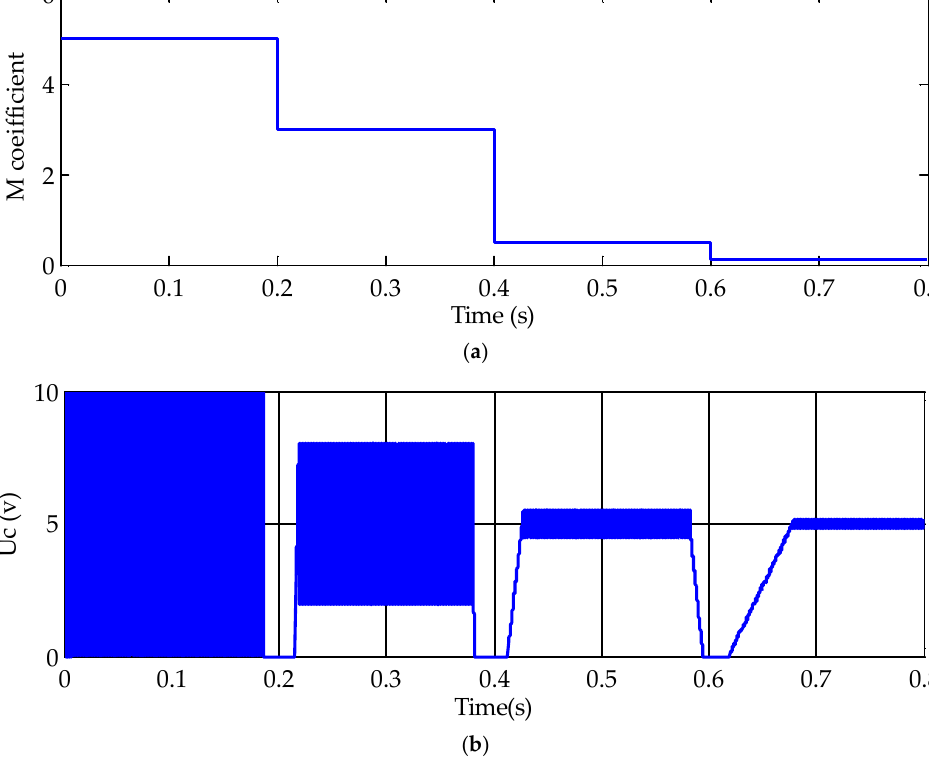
( c ) Figure 7. Discontinuous function coefficient effect: ( a ) evolution of M coefficient, ( b ) evolution of the control voltage and ( c ) evolution of the output voltages. 6.2. Controller’s Behavior under Abrupt Target Output Voltage Variations In this case, the aim is to test the tracking behavior of the proposed sliding mode controller against abrupt target output voltage variations. All five algorithms are imple- mented and simulated in the same test conditions. In fact, the load resistor, the input volt- age, and the DC-DC buck converter parameters are all maintained at their nominal values. The target output voltage is first fixed at 150 v. At t = 0.03 s, it changes to 350 v and de- creases to 250 v at t = 0.07 s. The five obtained output voltages and control signals are